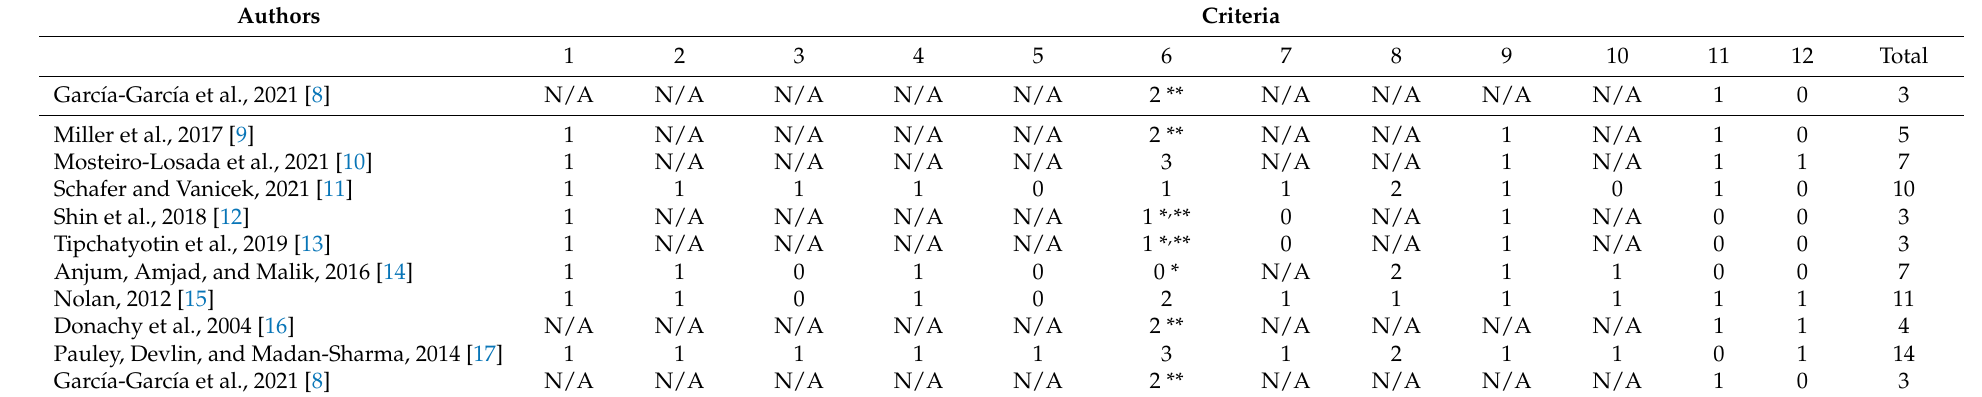
Table 3. TESTEX scale for analyzing the quality of studies.